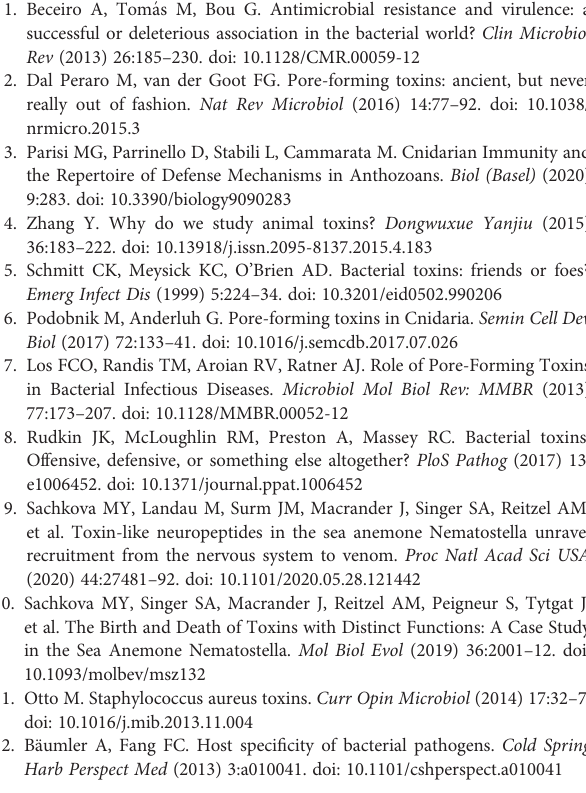
the small lobe in red and the large lobe containing the aerolysin motif (IPR005830) in green. Structural domains according to the predicted structure of biomphalysin 1 are colored coded with domain 1 in red, domain 2 in green, domain 3 in blue and domain 4 in purple. The predicted residues involved in mannose binding are shown in a yellow box. Supplementary Figure 3 | TMD characterization in biomphalysin proteins. (A) Multiple alignment of the region surrounding the transmembrane domain of all biomphalysin proteins was performed using the HHpred server. The Transmembrane Domain boxed in blue was predicted using the PRED – TMBB server and confronted to the TMD of aerolysin protein (AFP82959) from Aeromonas hydrophyla . Hydrophylics (Ser and Thr) and Hydrophobics (Val, Ile, Leu and Ala) are shown in red and blue respectively. (B) A hydropathy plot of the predicted TMD from all biomphalysin proteins was done by the method of Kyte and DooLittle (1982). An alternation of hydrophilic and hydrophobic residues was observed for all predicted TMD. For example, TMD sequence of biomphalysin 2 is given in this plot. (C) . Structure of the TMD of biomphalysin 2 was predicted by the I Tasser server from the complete sequence of the protein. Close view on TMD was generated by PyMOLWin. Beta sheets represented by arrows forms a beta hairpin similar to the loop region in domain III of aerolysin toxin. All biomphalysins contains a transmembrane beta hairpin required to drive membrane insertion. Supplementary Figure 4 | Carbohydrate binding site prediction on biomphalysin proteins. (A) Surface representation of biomphalysin16 protein interacting with alpha-D mannose-6-phosphate (PDB: M6P). M6P are shown as spherical structures with gray carbon, phosphate and oxygen atoms. Ribbon representation of biomphalysin 16 was superimposed on a transparent surface map. (B) Close-up of the binding site. Alpha-D mannose-6-phosphate bound to the predicted pocket is located in the domain II of biomphalysin protein. The predicted residues involved in mannose binding are